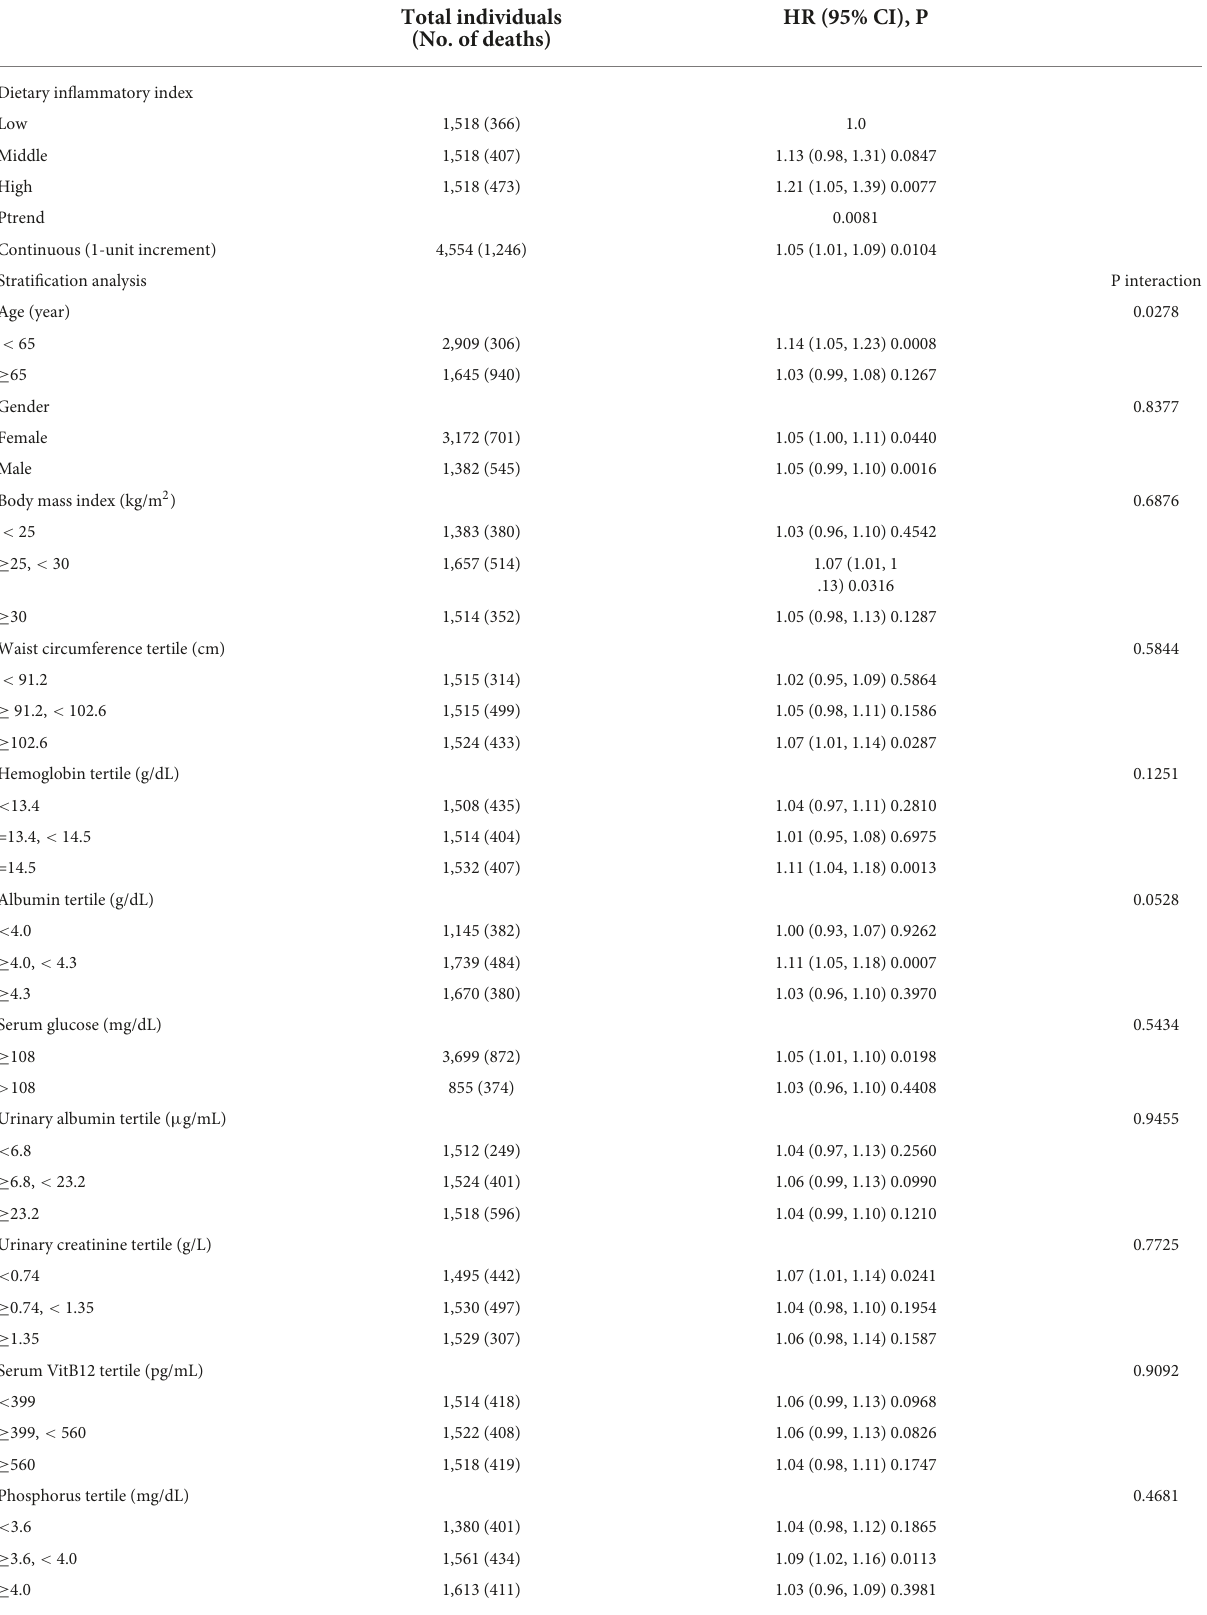
TABLE 2 Multivariate analysis of the dietary inflammatory index associated with all-cause mortality, stratified by potential effect modifiers. Total individuals (No. of